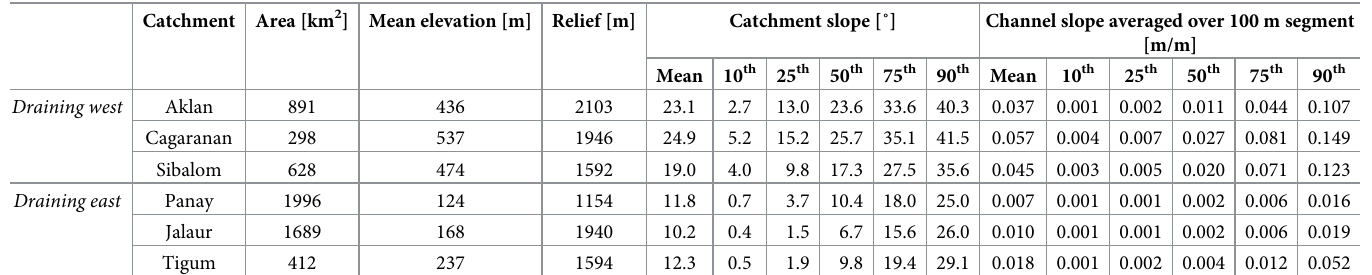
Table 4. Topographic attributes of the six catchments on Panay